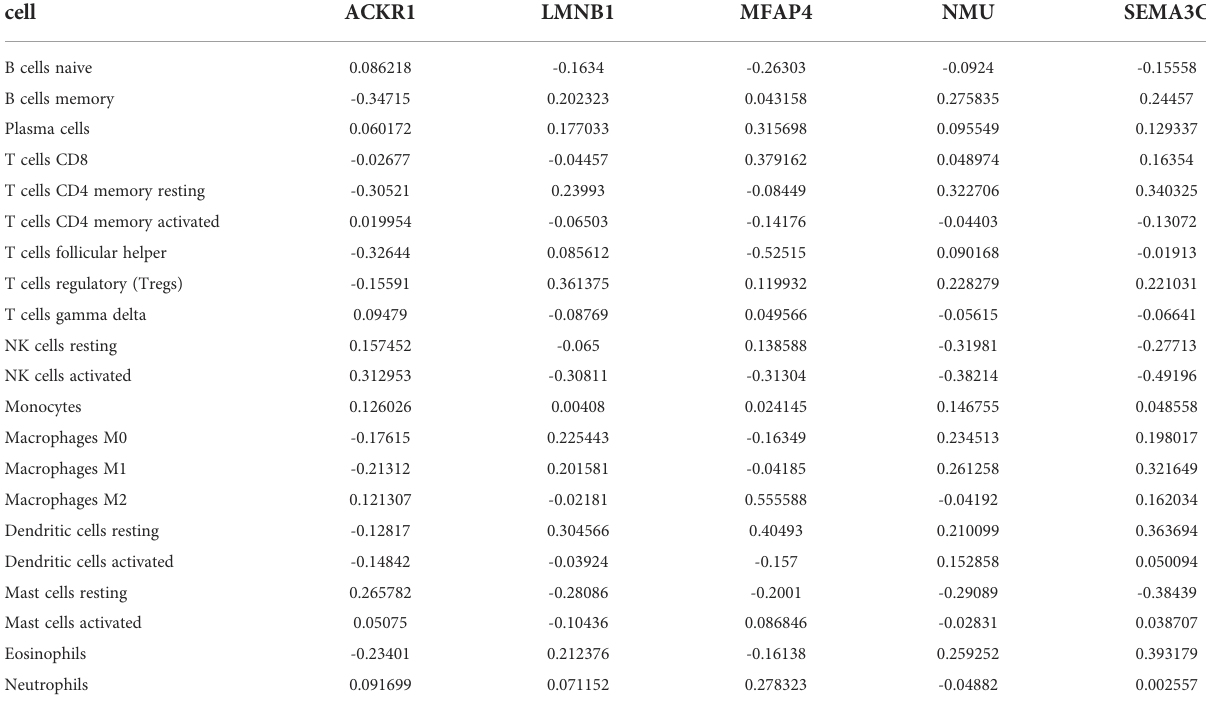
TABLE 3 Speci fi c R values and P values of correlation analysis between immune cell matrix obtained by CIBERSORT and all diagnostic markers R value. cell